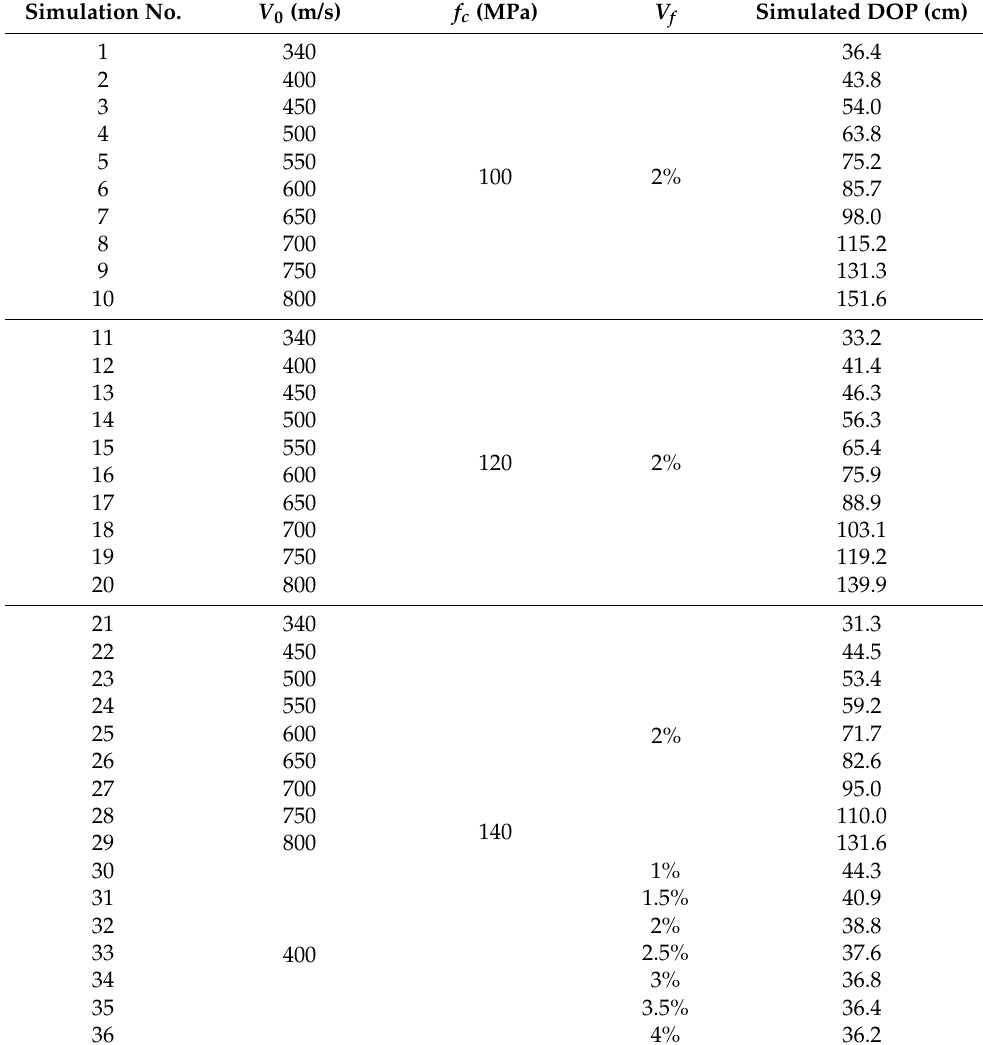
Table 6. Numerical results of the DOP. Simulation